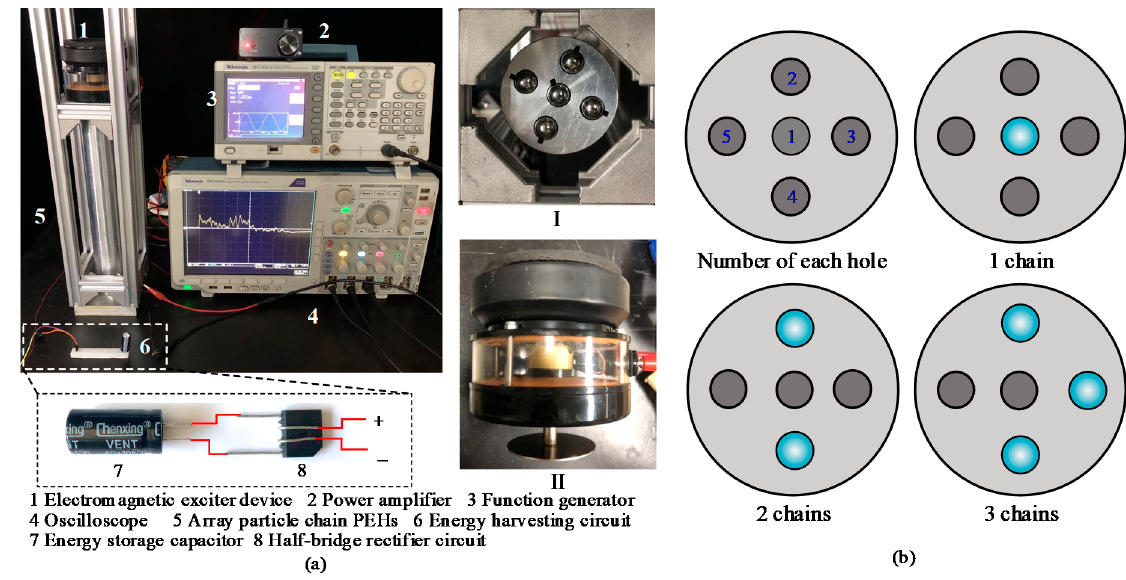
Figure 4. ( a ) Experimental set-up of the PEH based on multiple composite chains of particles and ( b ) layout of the impacted chains.